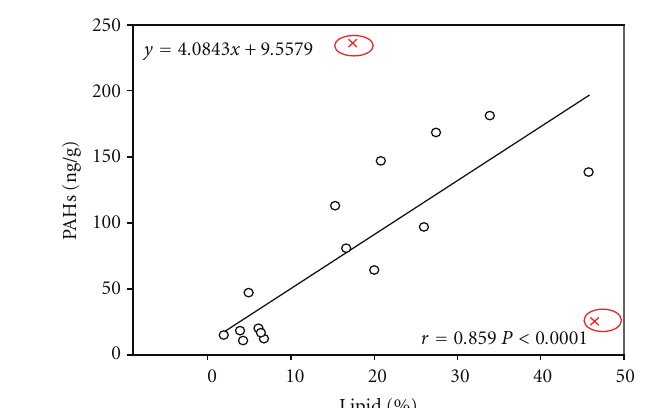
Figure 10: Correlations of lipid with PAHs in tissues of fishes. The two red points represent the samples (gill of tilapia and gill of red grass carp) which are not included in the correlation analysis.